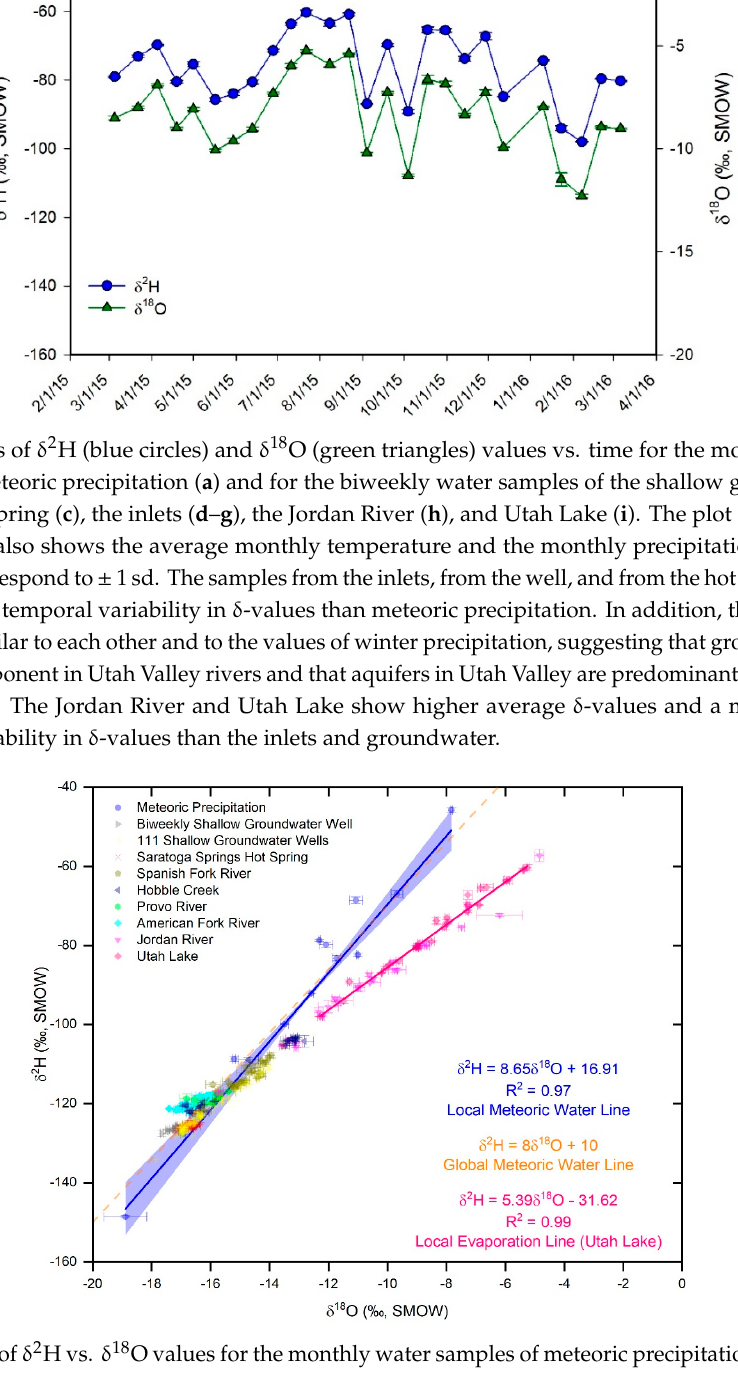
Figure 6. Plot of δ 2 H vs. δ 18 O values for the monthly water samples of meteoric precipitation, for all the samples of well water, and for the biweekly water samples of the hot spring, the inlets, the Jordan River, and Utah Lake. The plot also shows the local meteoric water line (LMWL) in blue with a 95% confidence band, the global meteoric water line, and the local evaporation line (LEL) for Utah Lake. Error bars correspond to ± 1 sd. The samples from the inlets, from the wells, and from the hot spring plot on or close to the LMWL, indicating their meteoric origin and suggesting that significant evaporation did not occur in these water bodies. In contrast, water samples from the Jordan River and Utah Lake plot on the right of the LMWL along well-defined LEL’s indicating that their water underwent significant